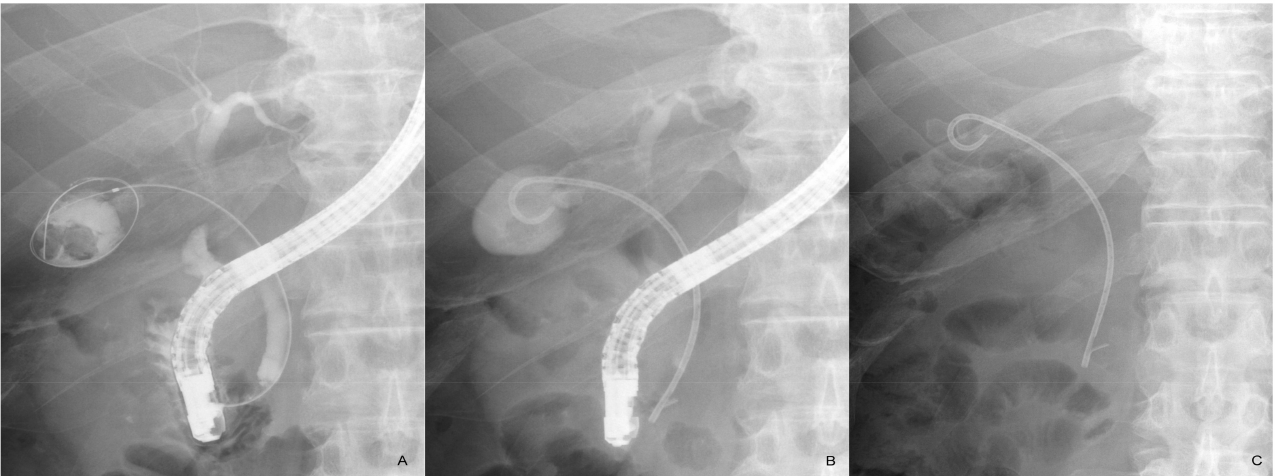
Figure 1. Endoscopic gallbladder stenting. The cystic duct is sought with a guidewire after biliary cannulation and the guidewire is inserted and placed in the gallbladder ( A ). A 7 Fr pigtail plastic stent is placed from the gallbladder to the duodenum ( B ). The stent remains in place 2 years after the procedure with no recurrent cholecystitis ( C